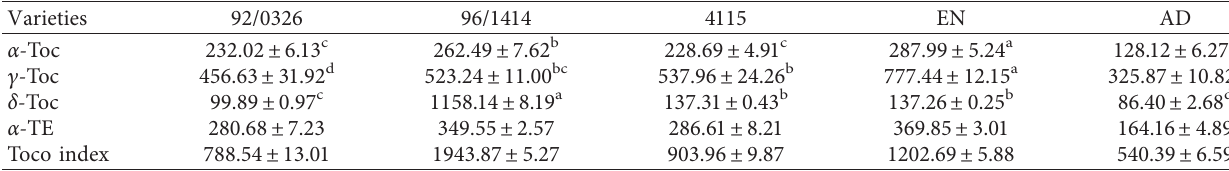
different. Table 2: Tocopherol isomers content of edible cassava leaf variety harvested in dry season at 9 months after planting (9MAP, 35–40 ° C, 00mm). Values are given in micrograms per 100 gram of sample dry weight basis ( μ